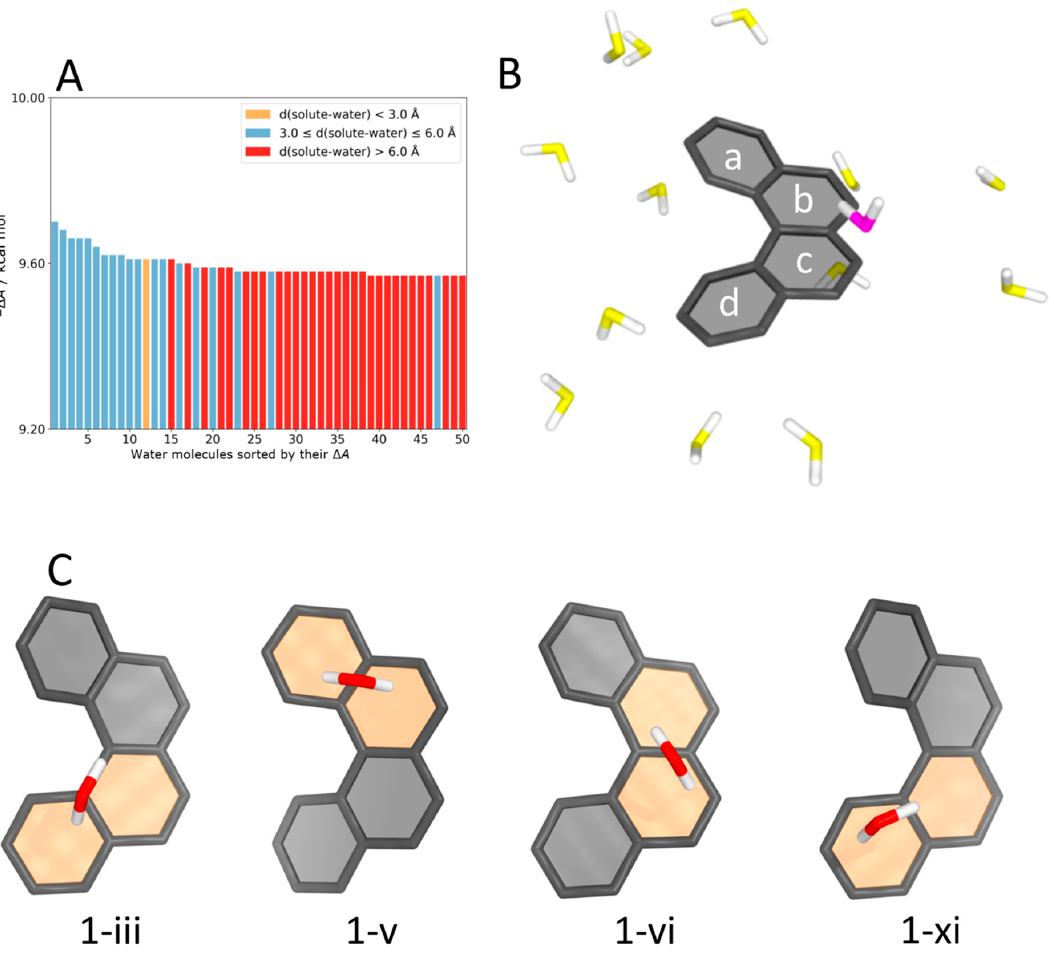
Figure 11. ( A ) FEBISS graph of [4]-helicene. ( B ) [4]-helicene with the 14 highest ranked water molecules as obtained from FEBISS, molecules are color-coded according to their ∆ A from favorable (magenta) to less favorable (yellow). ( C ) Representative low energy conformation of the [4]-helicene–(H 2 O) cluster after quantum chemical optimization (B3LYP/def-TZVP/D3). The orange area highlights the aromatic ring, which interacts with the explicit water molecule. Roman numbers indicate the rank of the water position in the FEBISS bar chart.